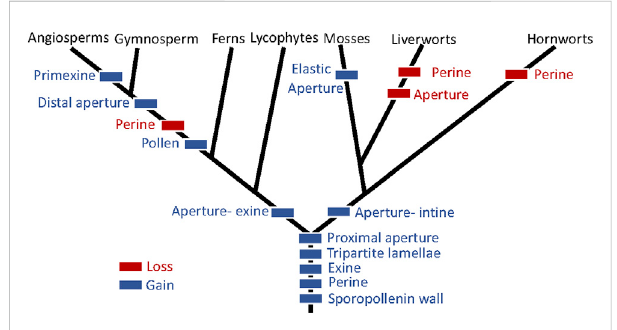
FIGURE 10 Evolution of spore and pollen wall features based on bryophyte and tracheophyte monophyly and the setaphyte hypothesis (Puttick et al., 2018; Renzaglia et al.,